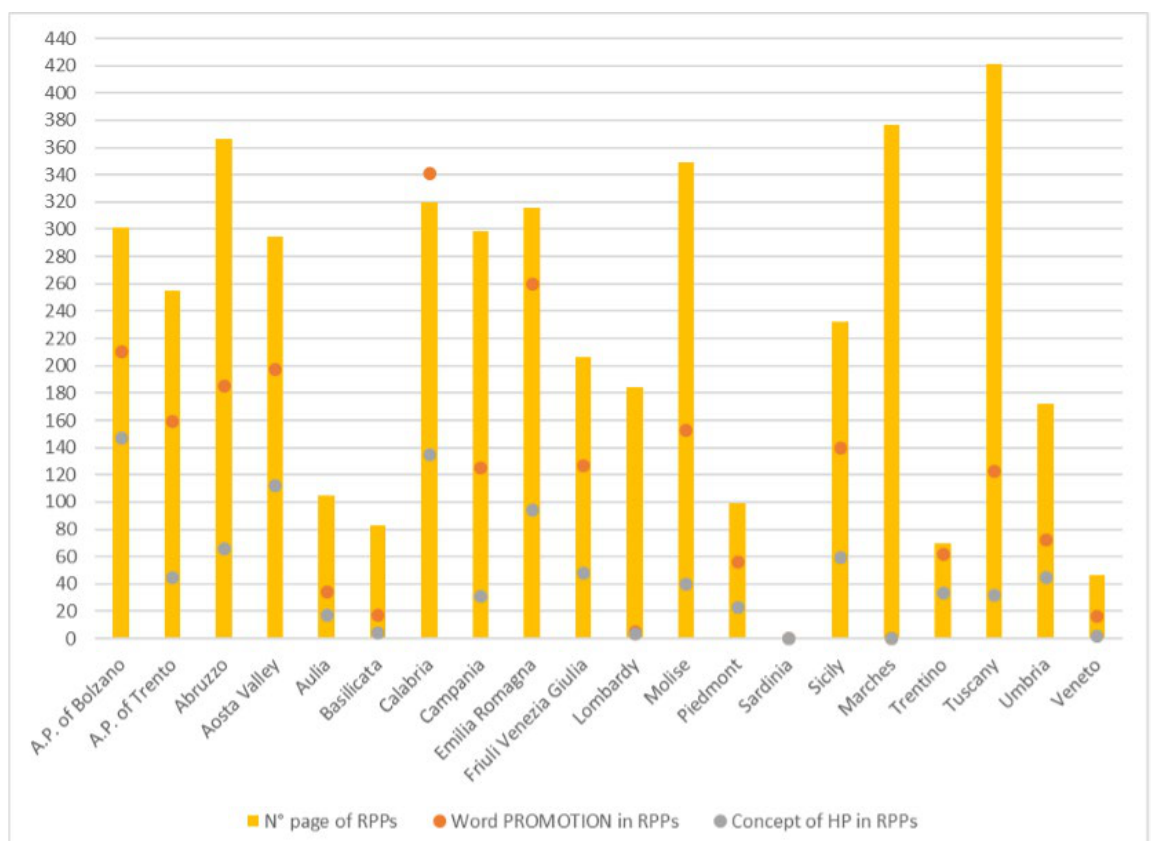
Figure 1. Comparison of document consistency and health promotion expression, in terms of word count and concept.